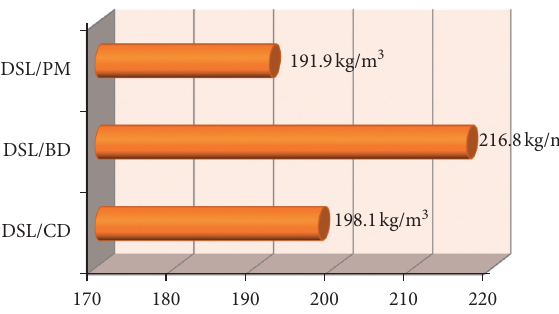
Figure 1: BDs of the briquettes with different binders.